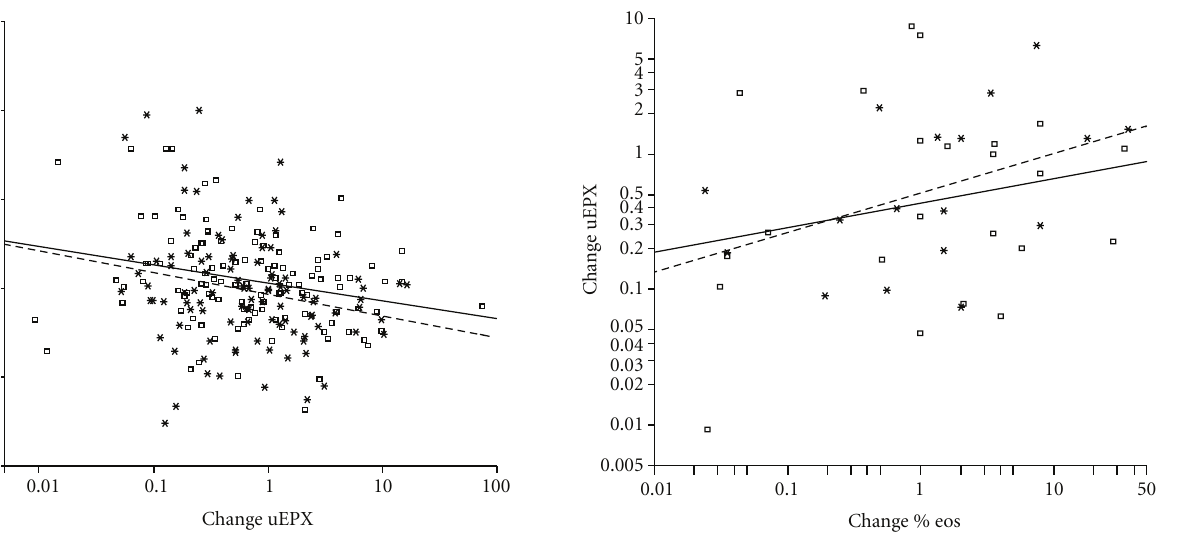
F 2: Scatterplot of within-patient changes from baseline in F 3: Scatterplot of within-patient changes from baseline in forced expiratory volume in 1 second versus changes in uEPX. uEPX versus changes in percentage sputum eosinophils. Squares Squares and the solid regression line pertain to changes between and the solid regression line pertain to the changes between baseline baselineand1-year-followup;asterisksandthedashedlinerepresent and 1 year ( ); asterisks and the dashed line represent changes changes between baseline and 2years. Changes of uEPX are shown between baseline and 2 years ( ). Changes of uEPX and are shown as absolute differences of as ratios; changes of FEV percentage sputum eosinophils are both shown as 𝑛𝑛 𝑃 𝑛𝑛 percentage predicted values. 𝑛𝑛 𝑃 1𝑛 1